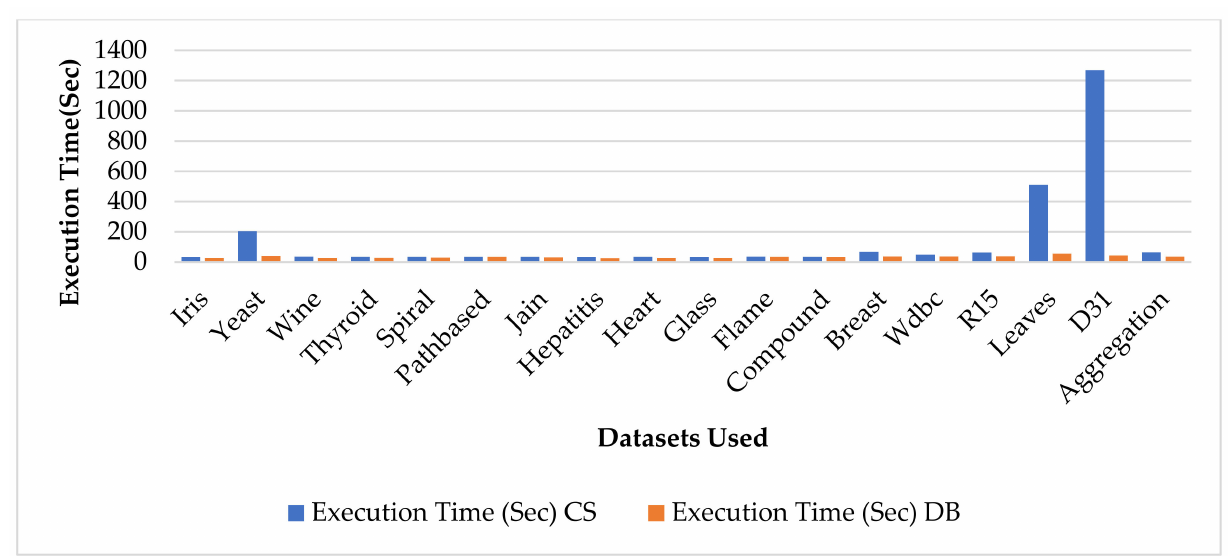
Figure 7. Average execution time taken by HVSFAPSO on CS and DB indices for all the datasets used over 20 independent runs.